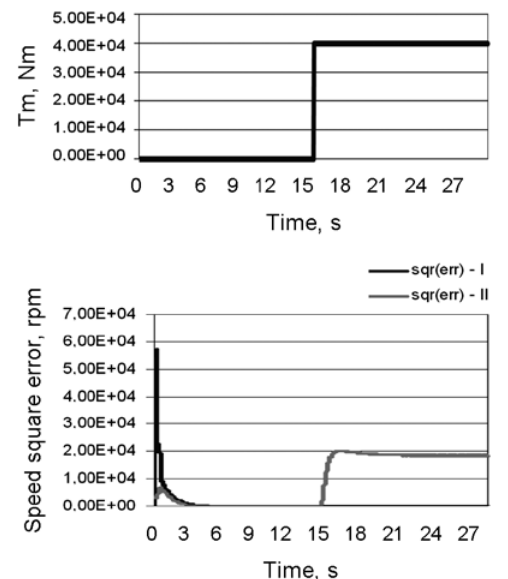
Fig. 4. Load torque T m and related square error ( sqr(err) ) of speed for estimation in system I/II respectively during the attachment process of the BLDC drive to the